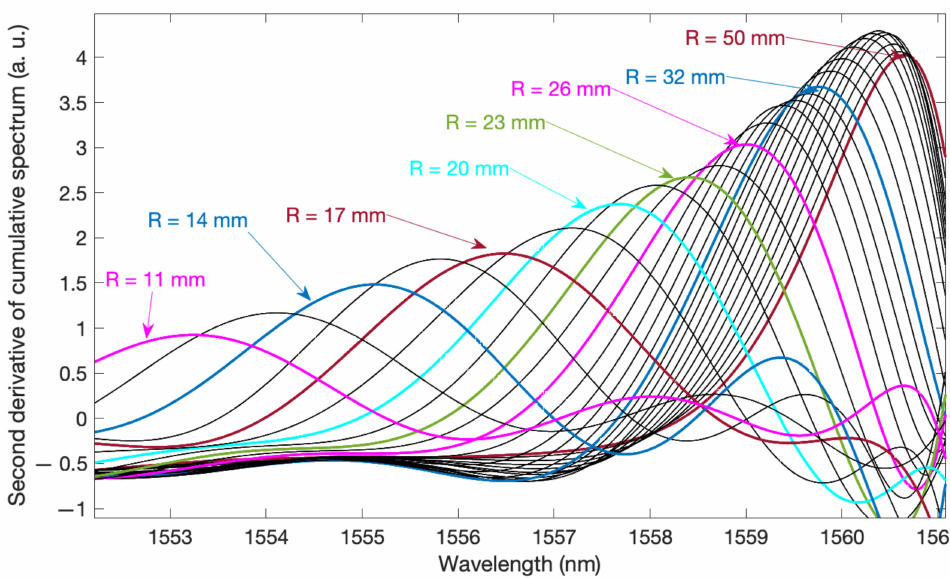
Figure 7. Second derivative of cumulative spectrum length.